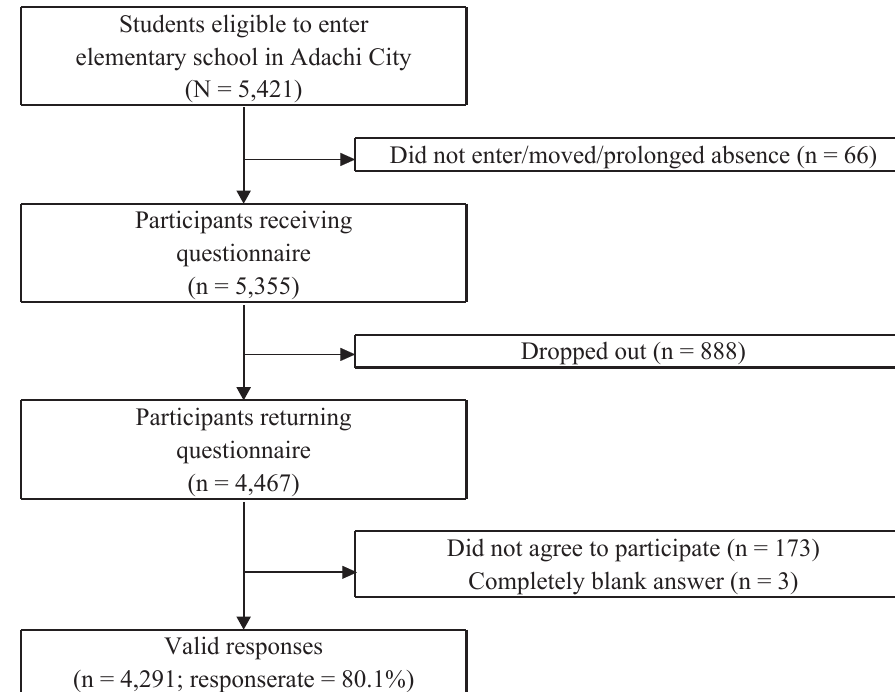
Figure 2. Flowchart of analytical sample of A-CHILD in fi rst wave in